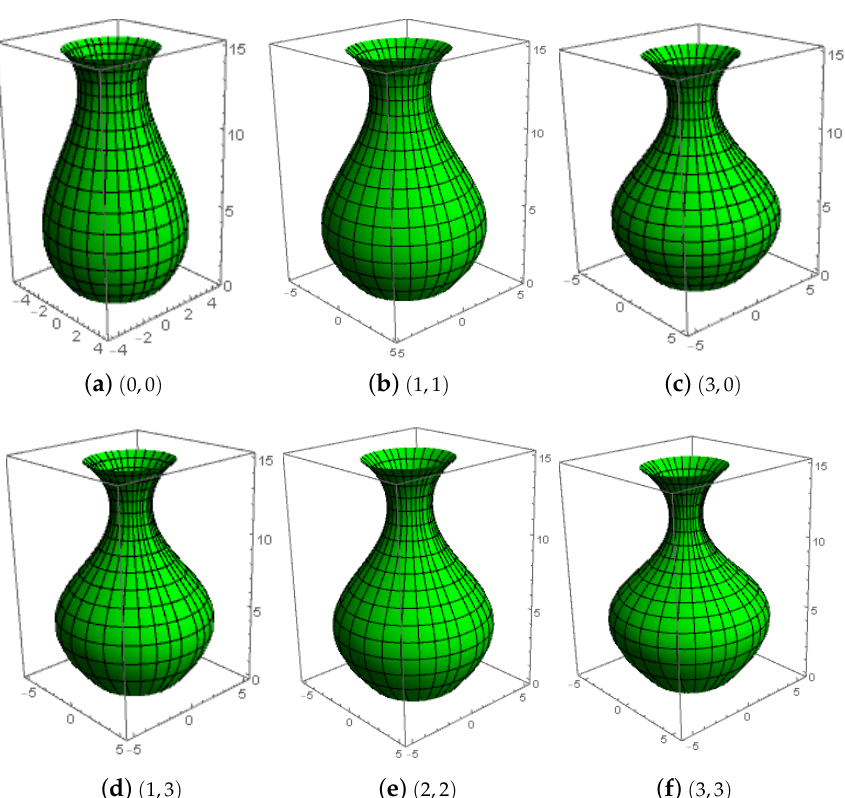
Figure 6. Recognition of the vase as a Bézier-like symmetrical rotation surface with different values of shape parameters χ and ϑ .